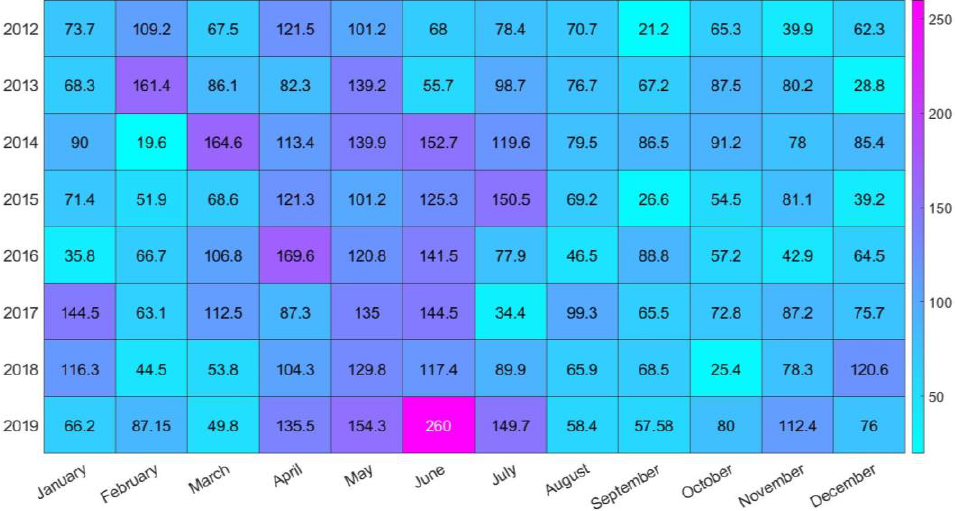
Figure 9. Precipitation heat map of P68 station.